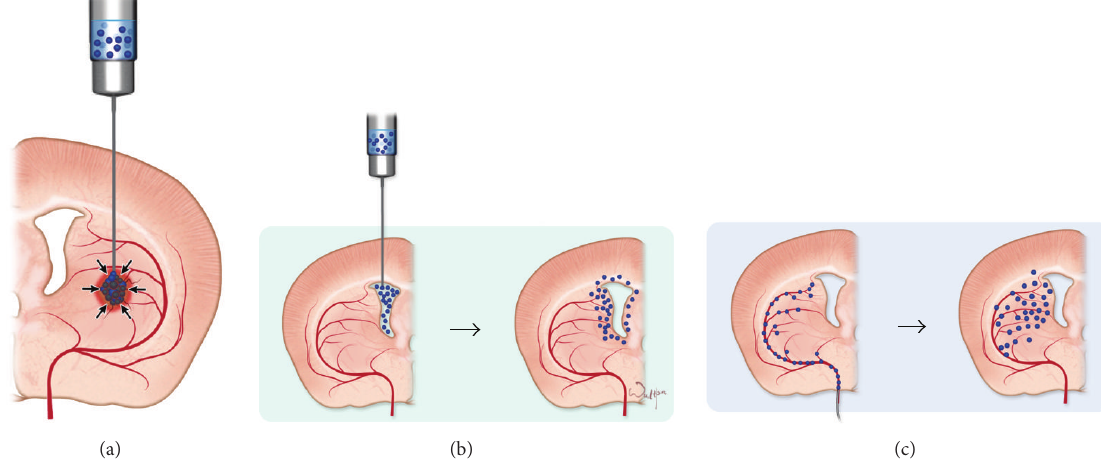
Figure 1: The role of migration in various routes of cell delivery. (a) Intraparenchymal injection triggers inflammatory responses and may augment the host reaction against the graft (arrows). Single stem cell infiltration of brain parenchyma after intraventricular (b) and intra- arterial (c)